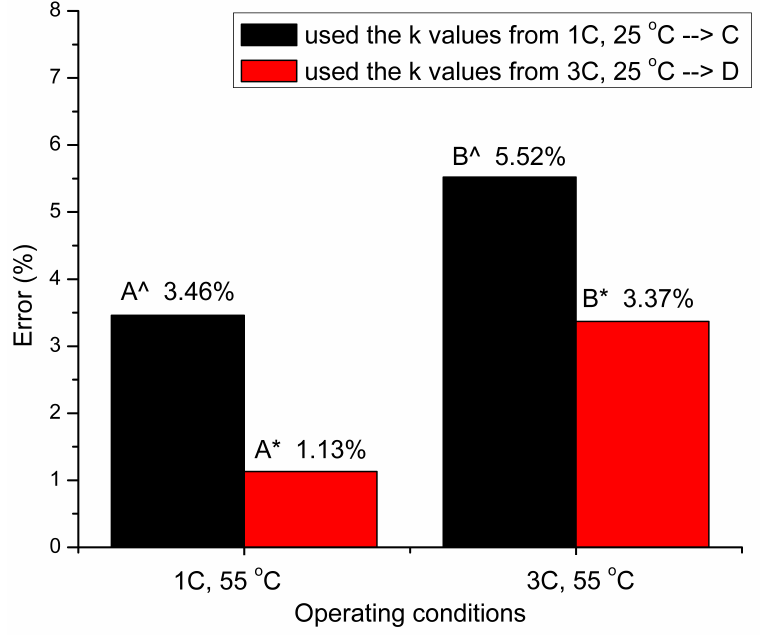
Figure 8. Estimation % error using k values from 25 ◦